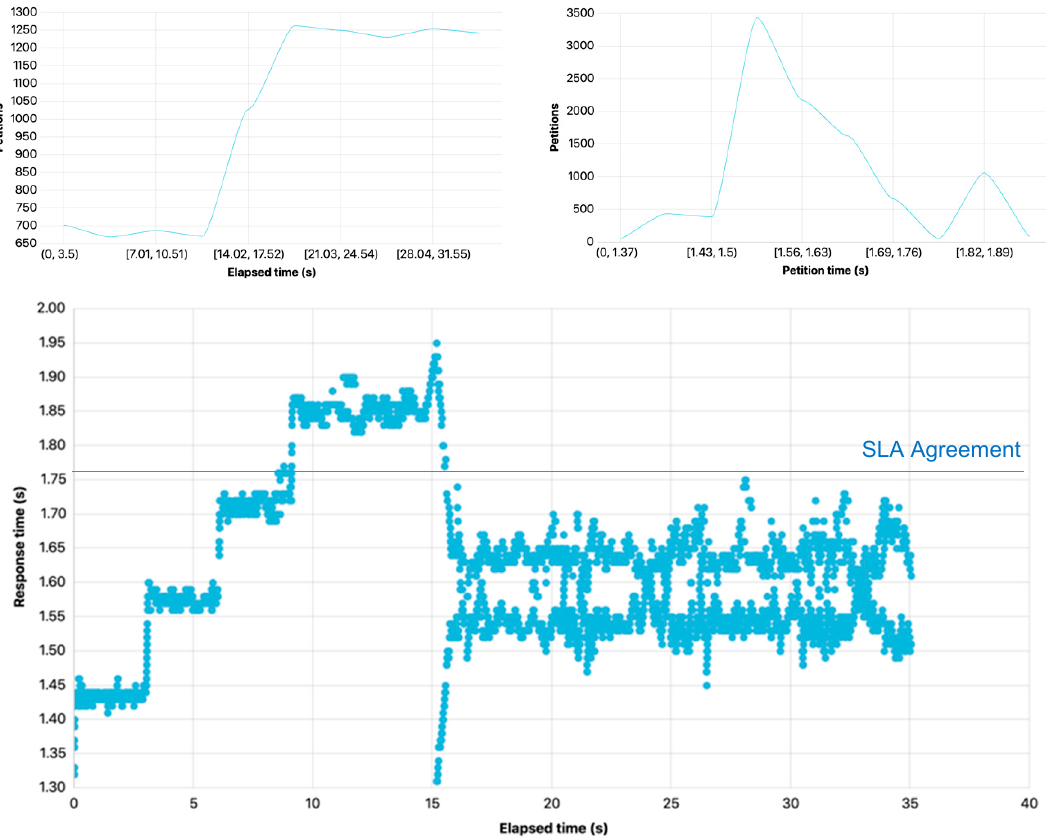
Figure 8. Experiment 2: Readjustment of the infrastructure resources for the method “GetSize” (( top left ) increase in request; ( top right ) time response of request; ( bottom ) whole adaptation process).